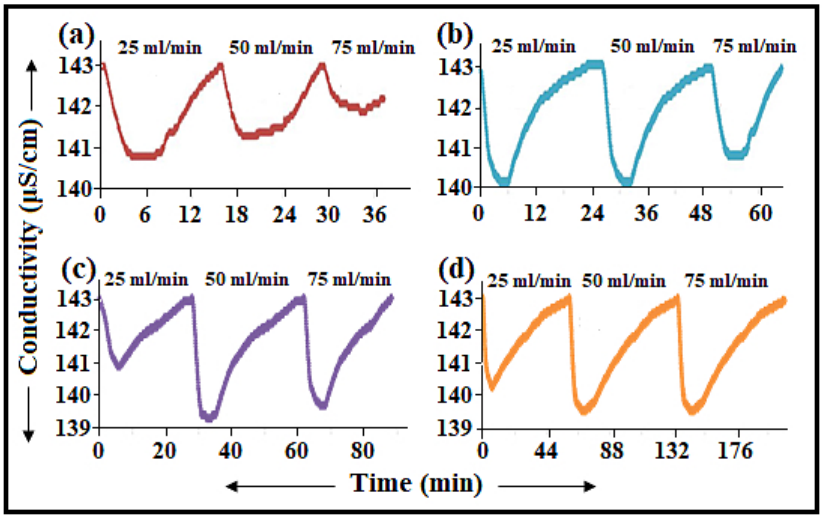
Figure 4. Variations in the conductivity of in the adsorption and release of NaCl solution at different applied flow rates and operating times when measured at 1.5 V: ( a ) 3.63 wt%; ( b ) 12.50 wt%; ( c ) 17.43 wt%; and ( d ) 23.58 wt% a-SWCNT-coated RVC